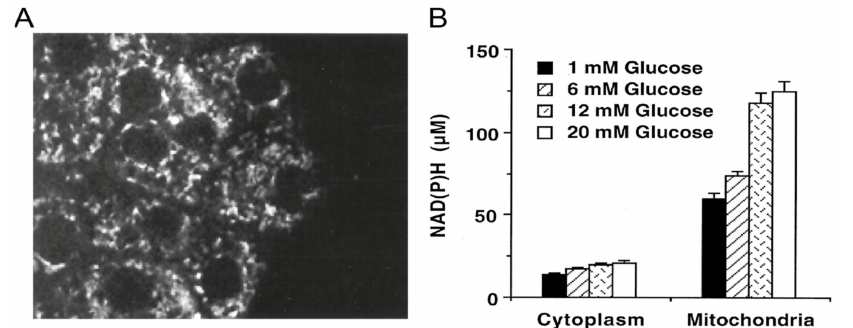
Figure 2. NAD(P)H intensity analysis. ( A ) Two photon microscopy of NAD(P)H autofluorescence of a mouse islet. ( B ) Quantification (in µ M) of NAD(P)H abundance in cytoplasmic and mitochondrial regions for different glucose concentrations. Adapted from Patterson et al. [16] (Copyright (2000) National Academy of Sciences,